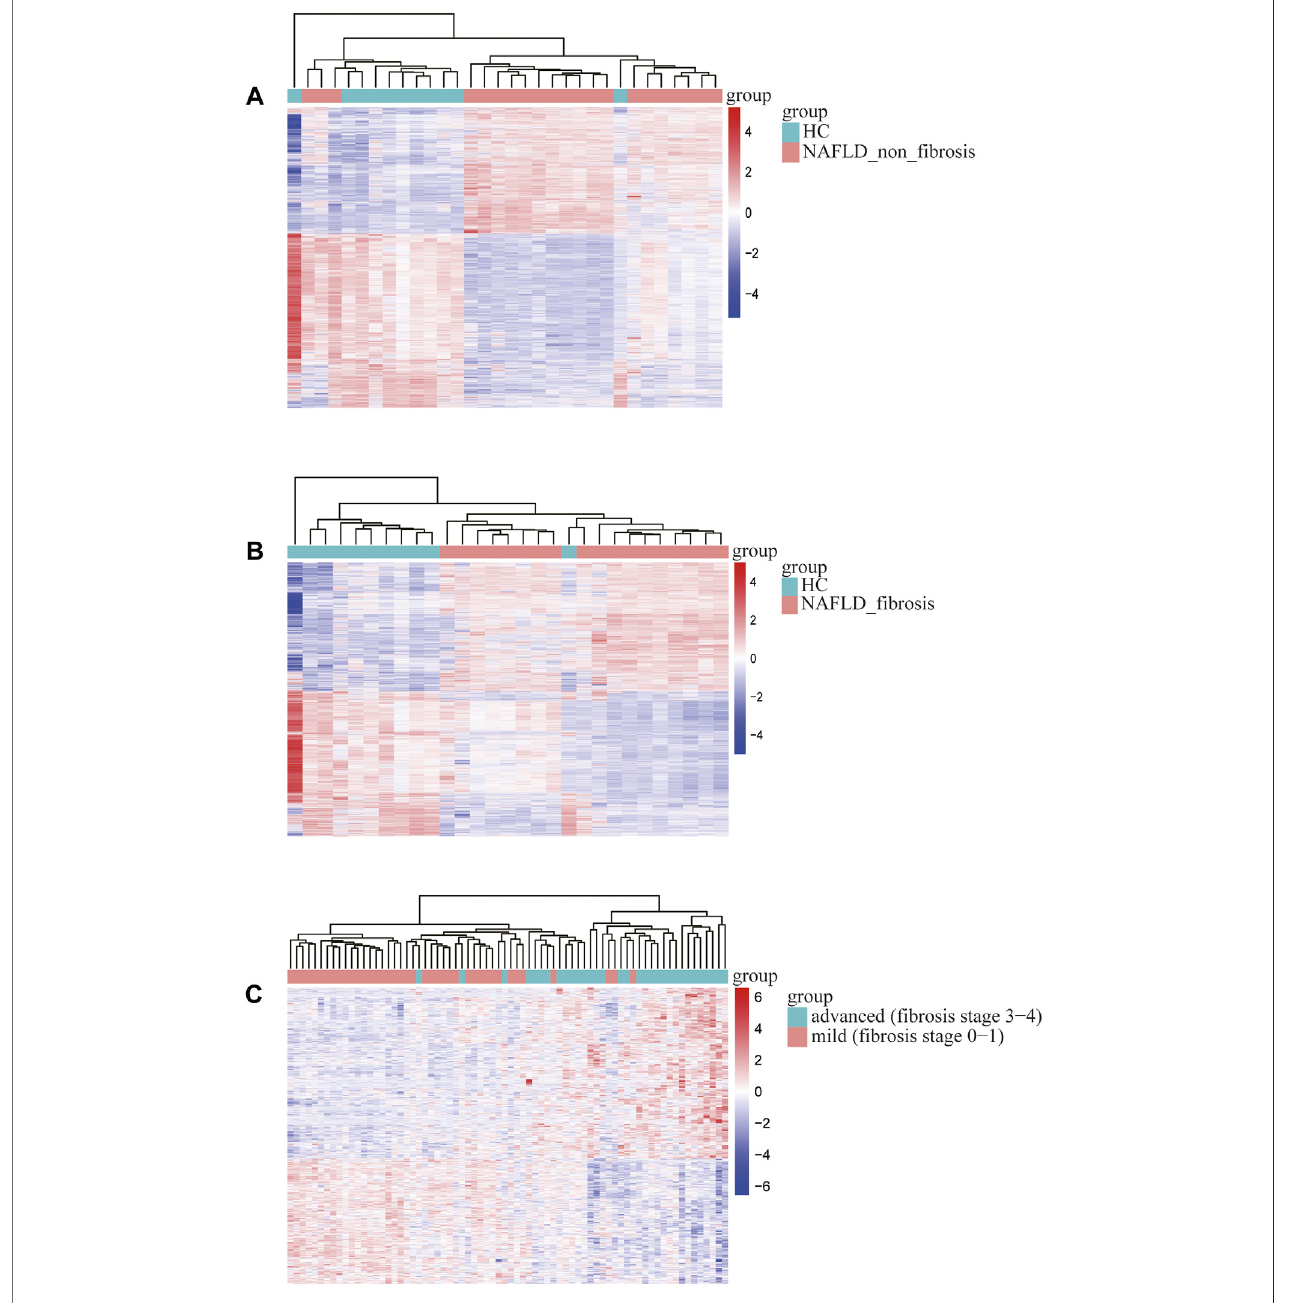
FIGURE 2 | Heatmap of differentially expressed genes identi fi ed in (A) non- fi brosis vs. HC group in GSE89632, (B) fi brosis vs. HC group in GSE89632, (C) advanced vs. mild fi brosis in GSE49541. Legend on the top right indicates the relative expression levels of the genes.